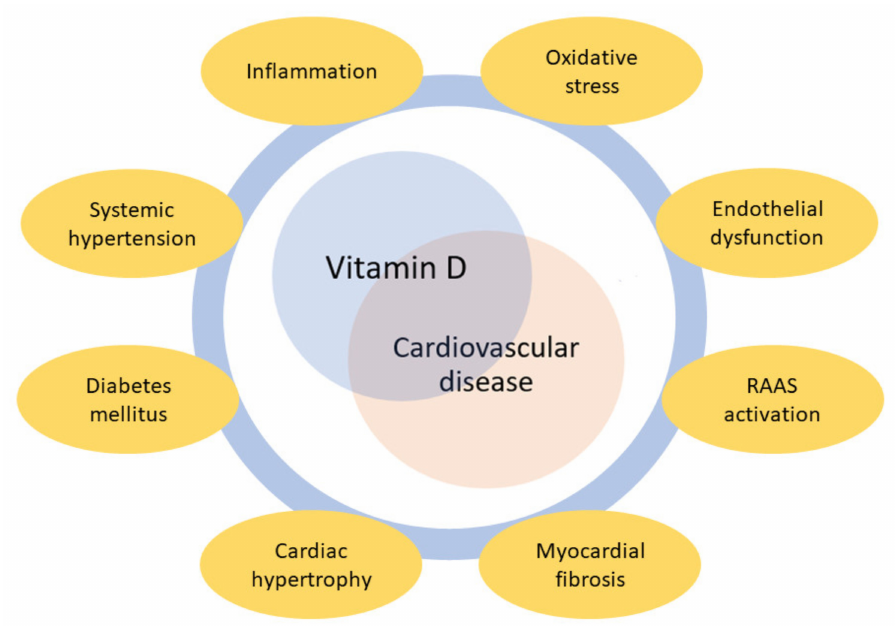
Figure 1. Major hypothetical mechanisms underlying the association between vitamin D and cardio- vascular disease. RAAS = renin–angiotensin–aldosterone